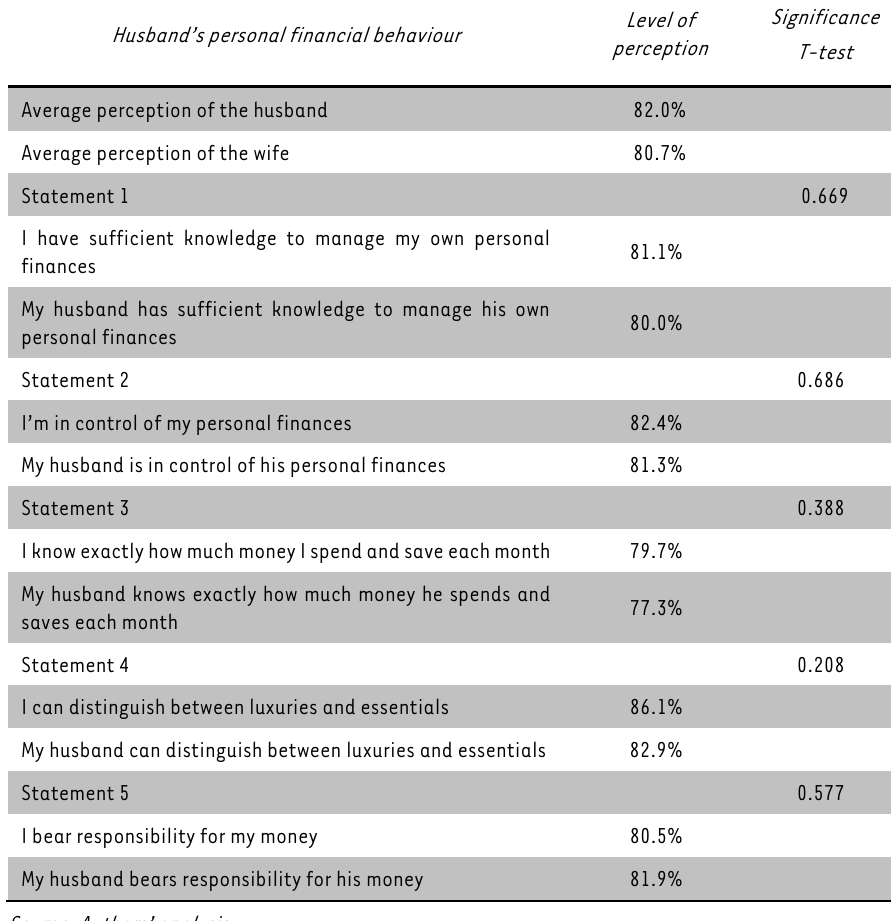
Perceptions of men and women about the husband’s financial